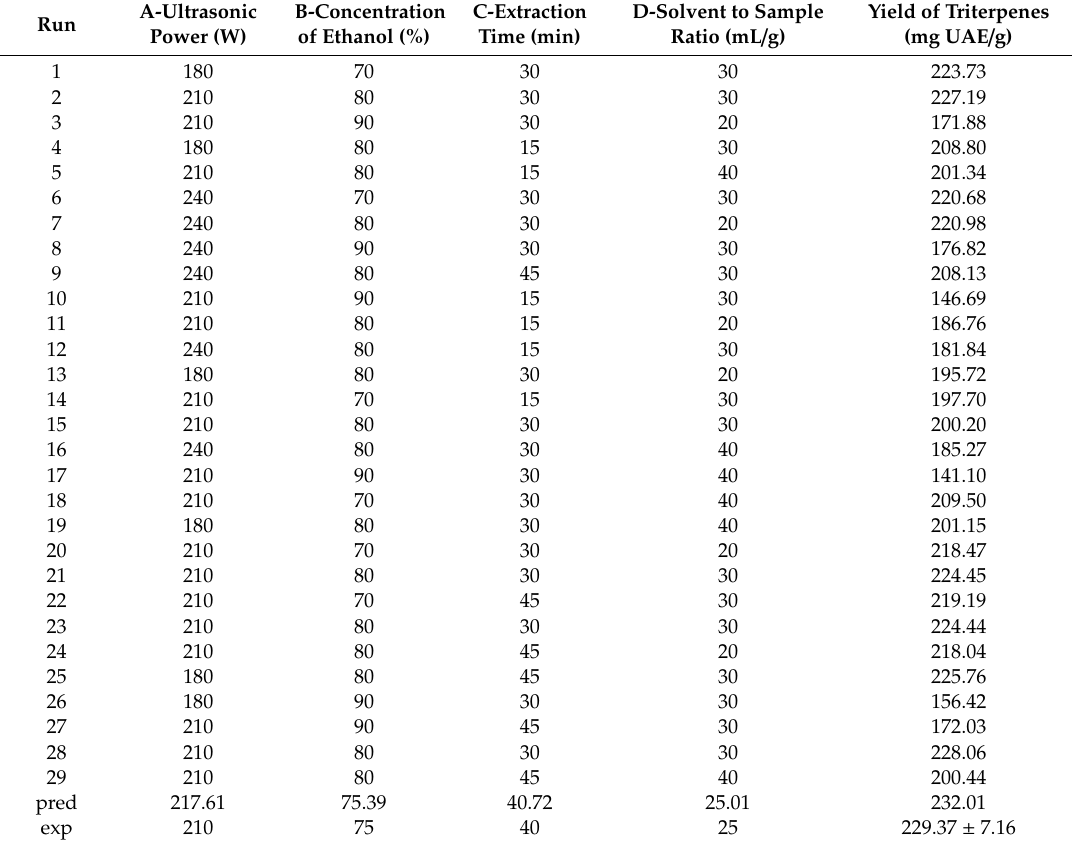
Table 1. The response surface method (RSM) design and results.